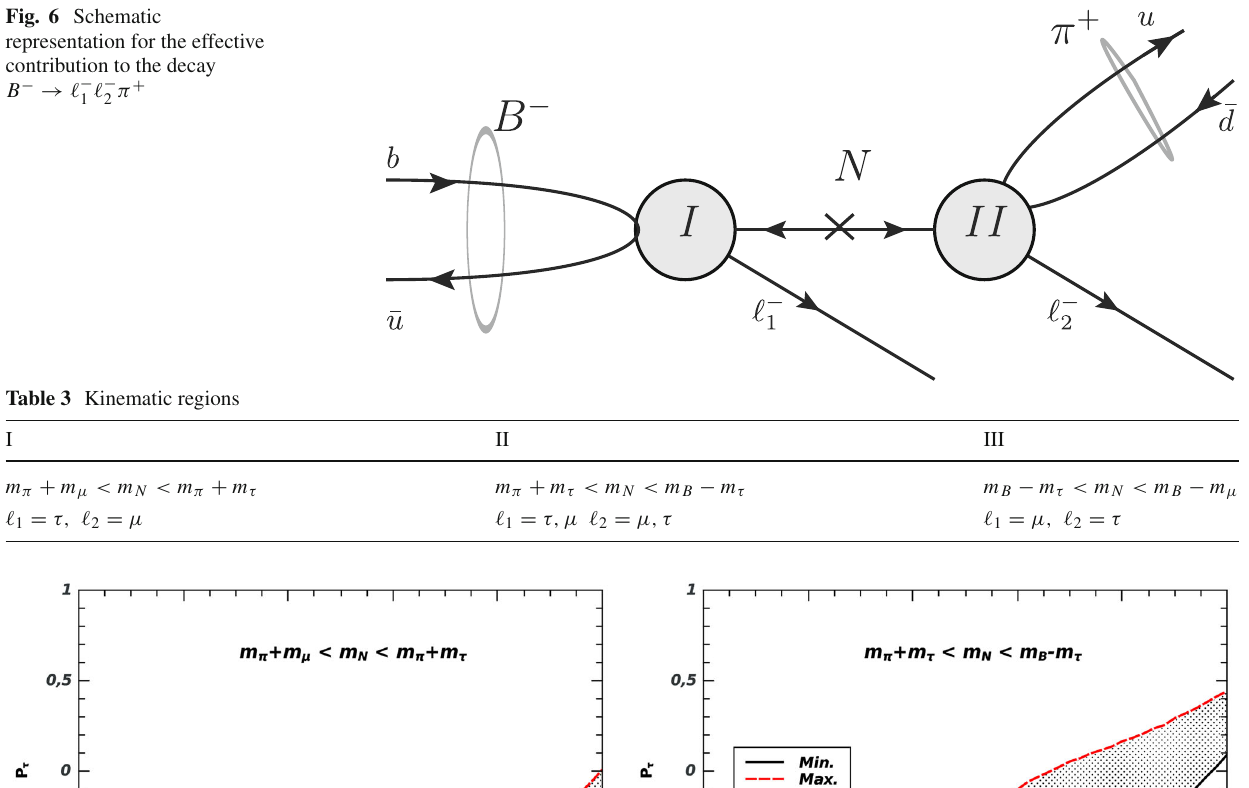
Fig. 6 Schematic representation for the effective contribution to the decay (cid:2) − π + B − → (cid:2) − 1 2